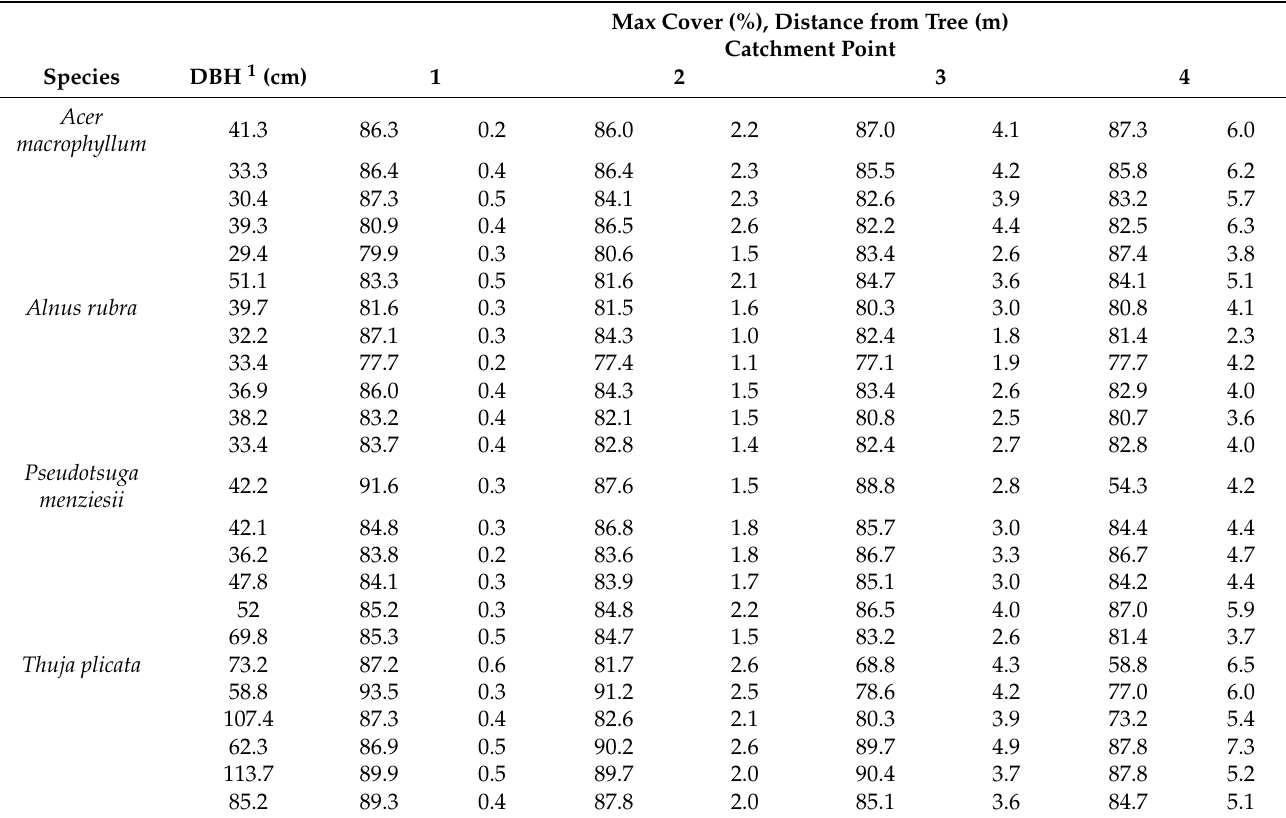
Table 1. Tree characteristics of the species used in this